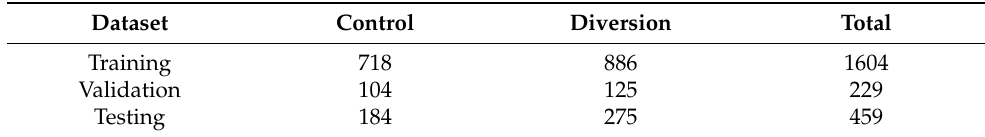
Table 1. Training, validation and testing sets